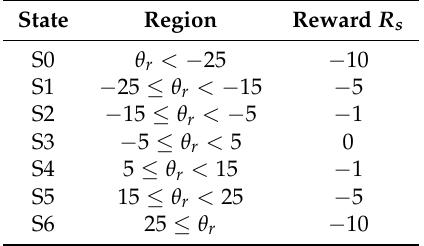
Table 3. The design space region and state